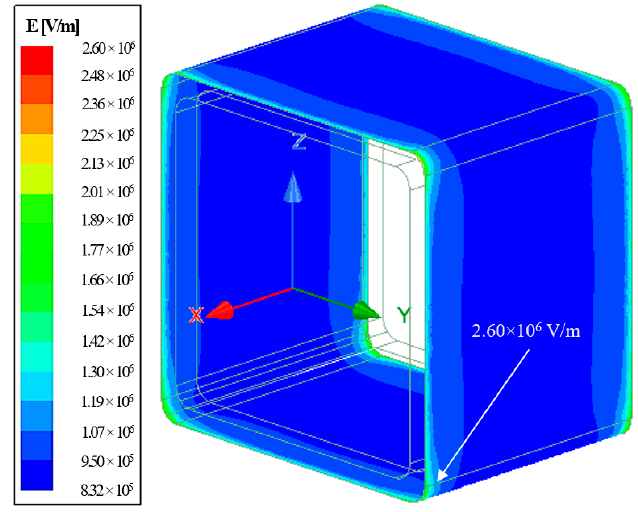
Figure 17. E ‐ field stress on the external surfaces of GFRP crossarm sample.